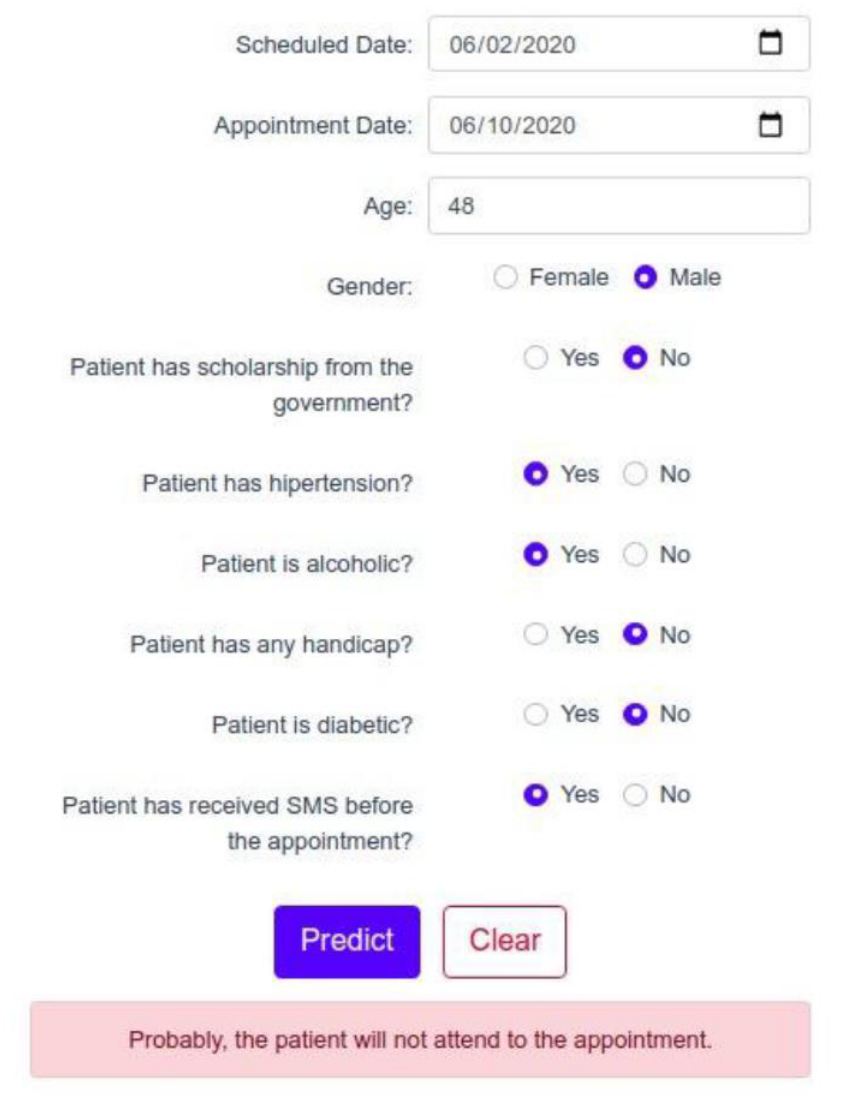
Figure 6. Example of using the developed web